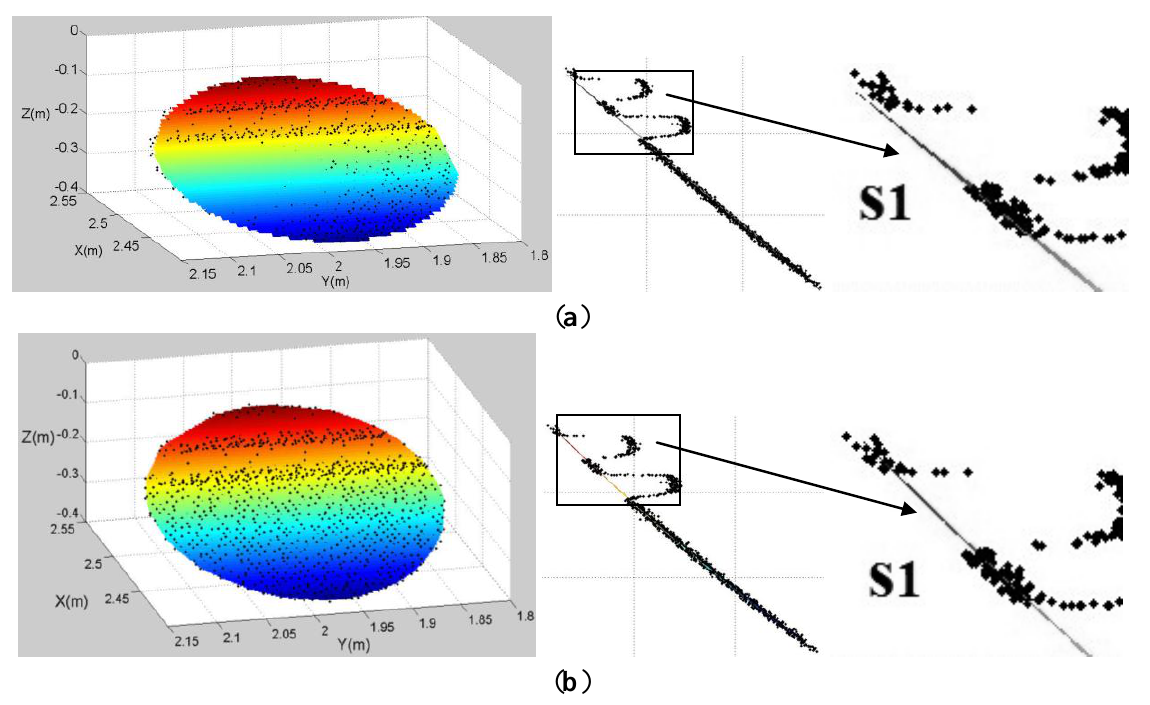
Figure 15. Fitting results of the laser point subset of a tunnel. ( a ) RANSAC; ( b ) Optimized